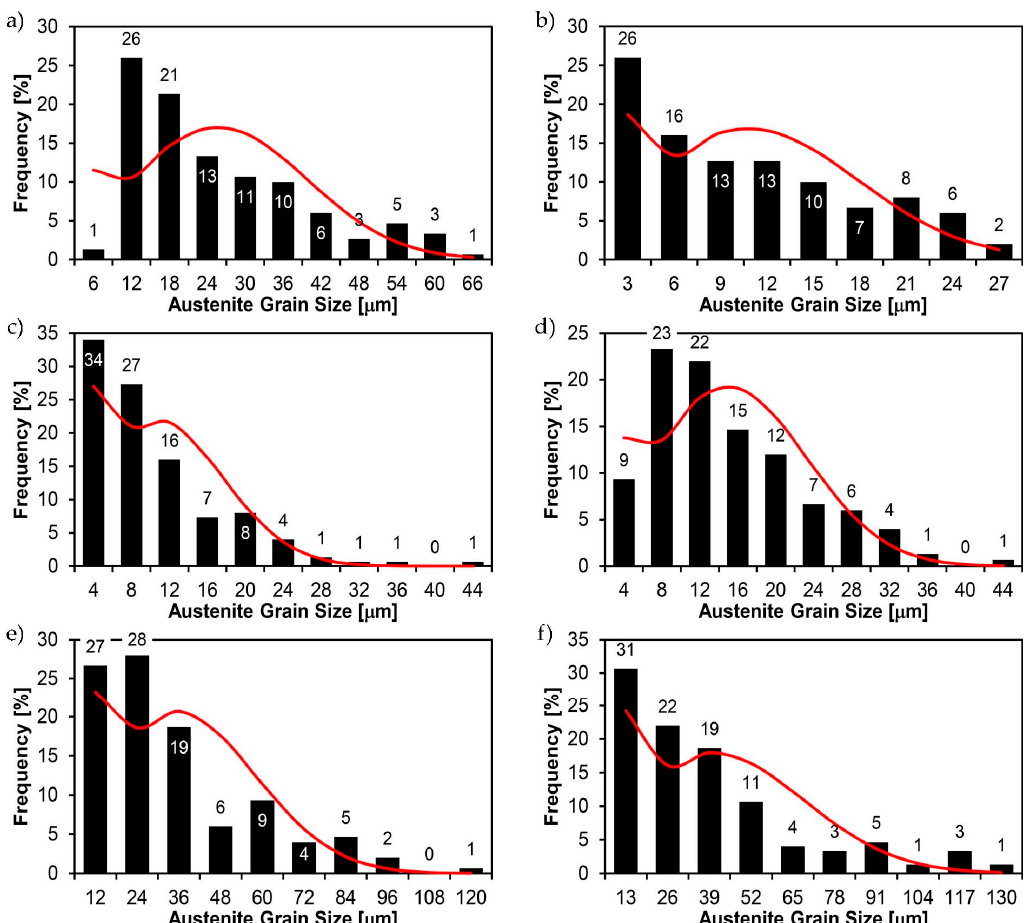
Figure 42. Frequency intervals and normal occurrence distributions of the determined grain sizes of prior austenite in the welded joint zone of Hardox 450 steel marked as WM2 in Figure 2: ( a ) normalised state; ( b ) delivery state (directly after welding); ( c ) after austenitising at 900 ◦ C for 60 min; ( d ) after austenitising at 1000 ◦ C for 60 min; ( e ) after austenitising at 1100 ◦ C for 120 min; ( f ) after austenitising at 1200 ◦ C for 120